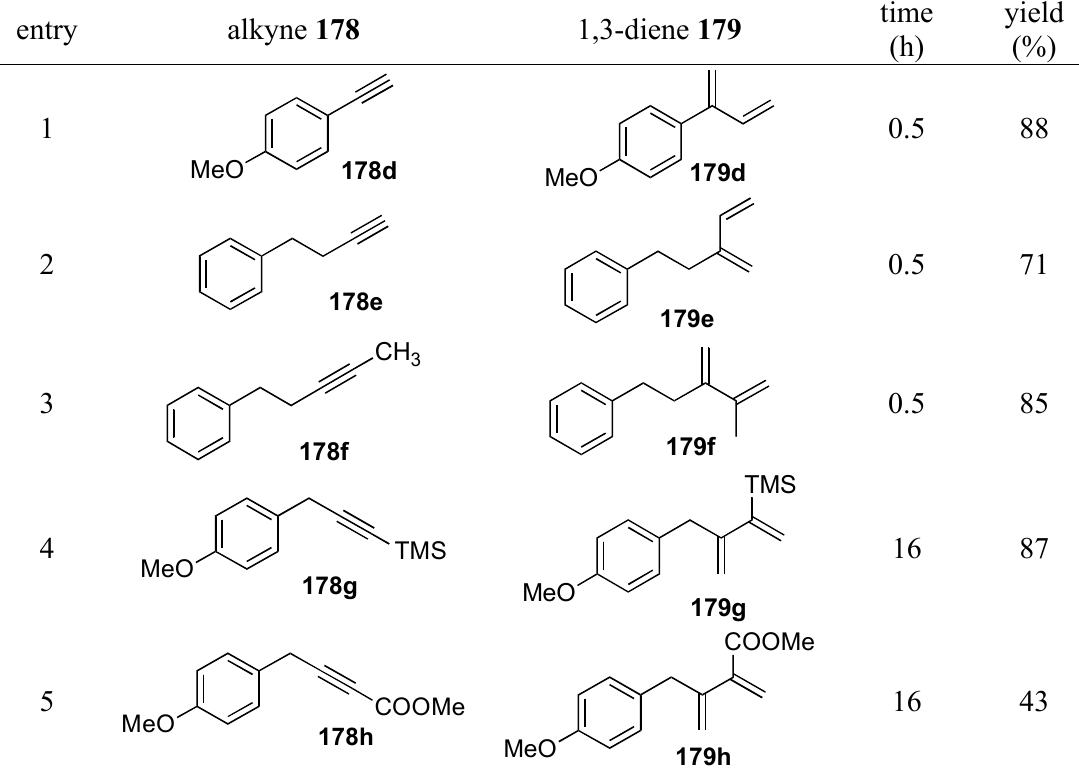
Table 1 . Synthesis of Various 1,3-dienes from alkyne and alkene using 1g . a